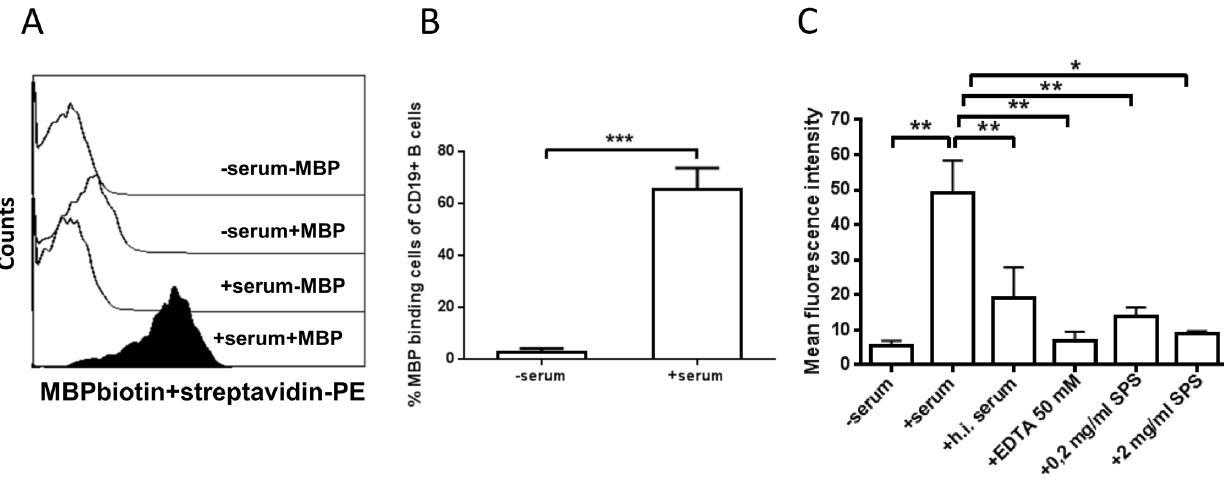
Figure 1. Serum complement promotes the binding of MBP to normal B cells. PBMCs from healthy donors were incubated for 30 min with or without 30 m g/ml biotinylated MBP in medium containing normal serum (30% v/v), or in pure medium. (A) Histogram plot depicting MFI values of MBP binding to B cells in one representative healthy donor. B) The binding of MBP to B cells from 7 healthy donors is shown, expressed as percentage MBP-positive B cells. C) Before addition to the culture media, serum was treated in one of three ways: heat-inactivated (h.i.) by heating to 56 u C for 30 min, or supplemented with EDTA or sodium polyanethole sulphonate (SPS) in different concentrations. The resulting MFI values from 5–7 healthy donors are shown. Bars and error bars represent means and SEM *p , 0.05 **p , 0.01 and ***p ,